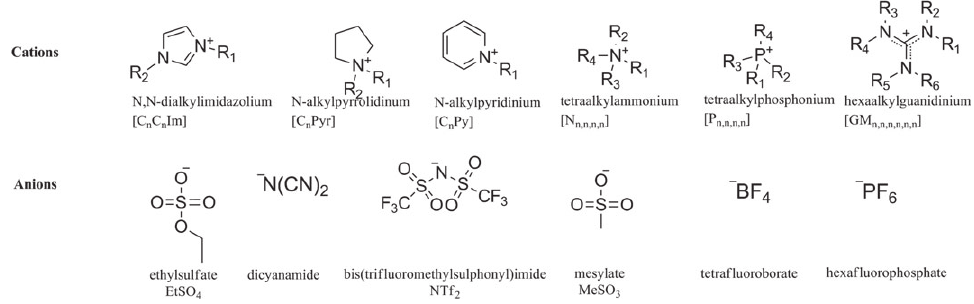
Figure 1 Examples of typical cations and